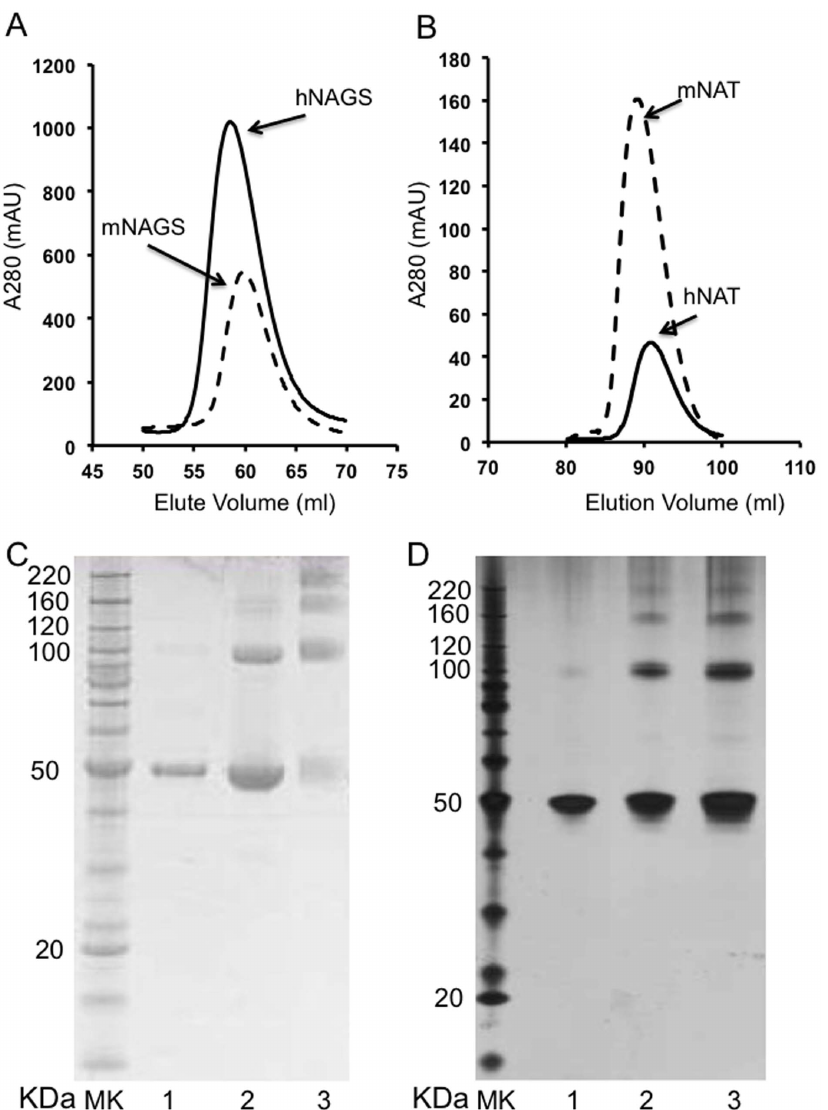
Figure 2. Oligomeric structure of mNAGS and hNAGS in solution. A: Analytic gel chromatography of mNAGS and hNAGS. Elution profiles of mNAGS and hNAGS are shown in dashed and solid lines, respectively. B: Analytic gel chromatography of mNAT and hNAT. Elution profiles of mNAT and hNAT are shown in dashed and solid lines, respectively. C: Cross-linking of mNAGS. Lanes 1; protein size markers; 2, mNAGS (2.5 m g) without cross-linking reagent; 3, mNAGS (2.5 m g) with cross-linking reagent, suberic acid bis(3-sulfo-N-hydroxysuccinimide ester) sodium salt; 4, mNAGS with cross-linking reagent, dimethyl suberimidate dihydrochloride. D: Cross-linking of mNAGS. Lanes 1; protein size markers; 2, mNAGS without cross- linking reagent; 3, mNAGS (1.5 m g) with cross-linking reagent, dimethyl suberimidate dihydrochloride; 4, mNAGS (4.5 m g) with cross-linking reagent, dimethyl suberimidate dihydrochloride.